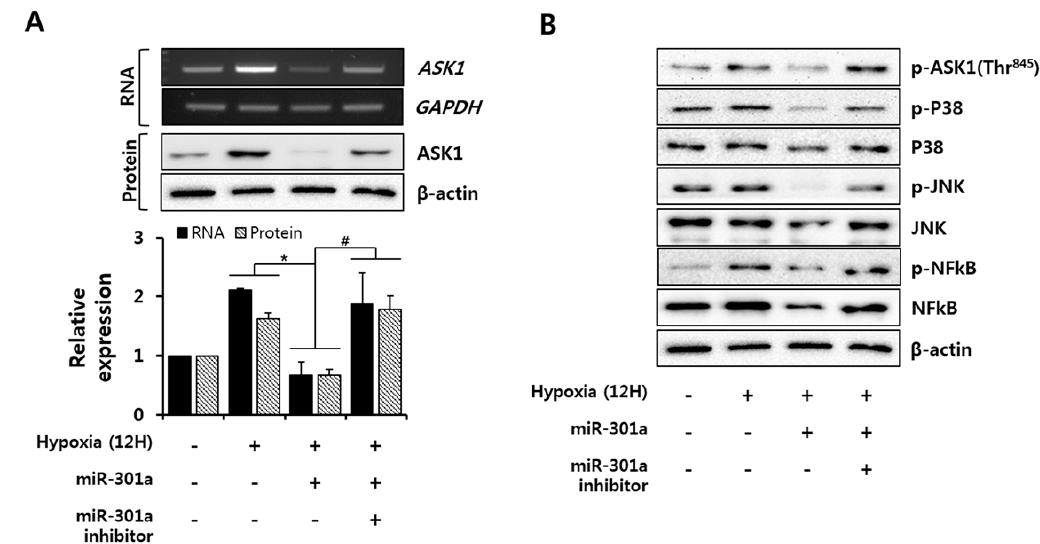
Figure 4. miRNA-301a inhibits the ASK1-related apoptotic pathway. ( A ) ASK1 mRNA and protein expression were measured by RT-PCR and immunoblot (* p < 0.001 vs. hypoxia, # p < 0.05 vs. inhibitor); ( B ) Expression and phosphorylation levels of ASK1-downstream molecules (JNK, p38, and NF κ B) were detected by immunoblot.